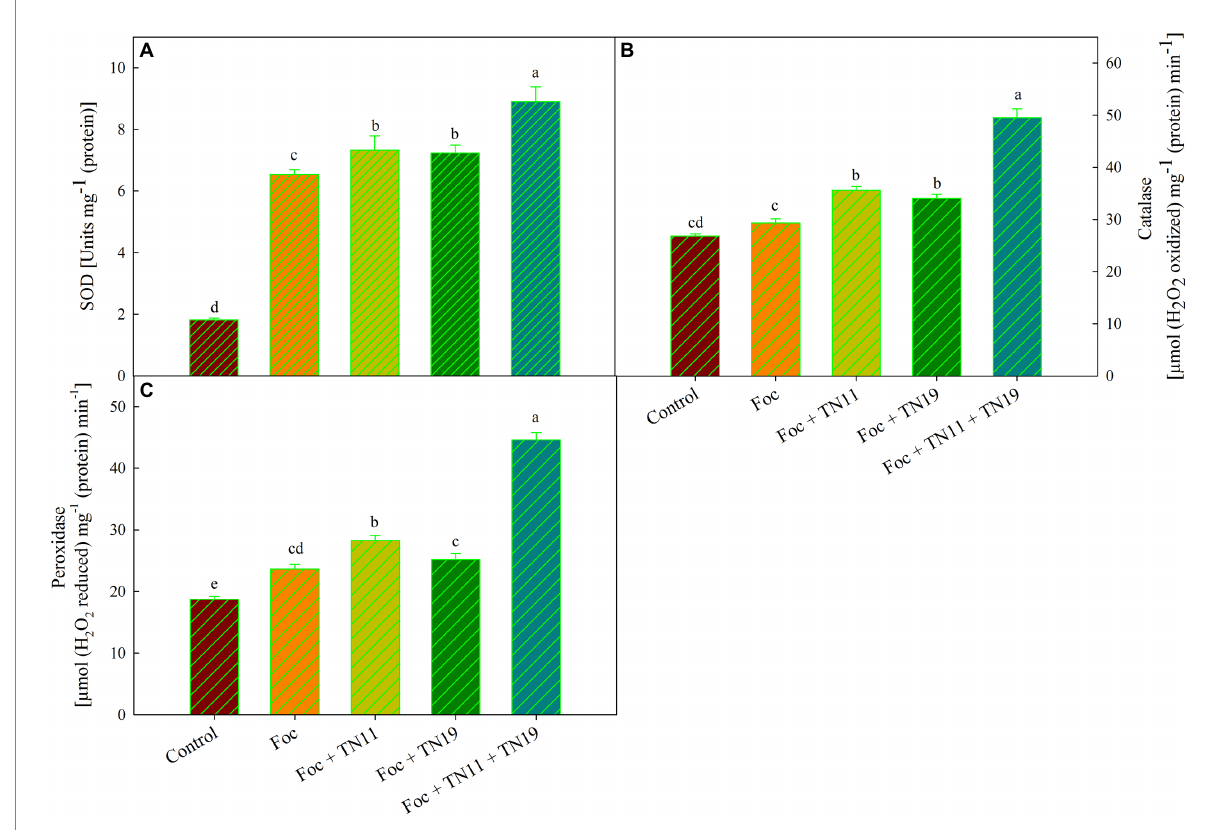
FIGURE 2 (A) Superoxide dismutase (SOD), (B) catalase (CAT), (C) peroxidase (POD), in chickpea leaves under unprimed control, Foc challenged, Foc challenged + TN11 primed, Foc challenged + TN19 primed, and Foc challenged + TN11 + TN19 primed. The data are the mean of three replicates ± standard error, within each graph, values followed by the same letter are not significantly different (p ≤ 0.05) according to Duncan’s multiple range